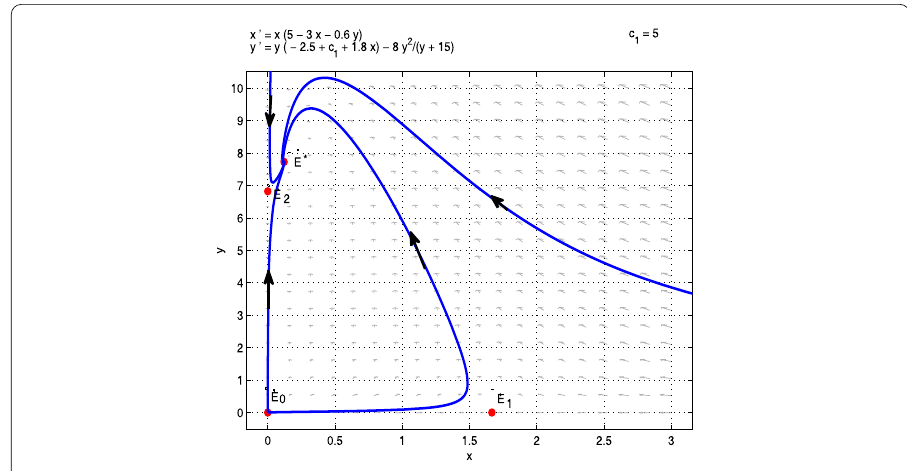
Figure 9 Dynamic behaviors of system (4.4) if c 1 = 5